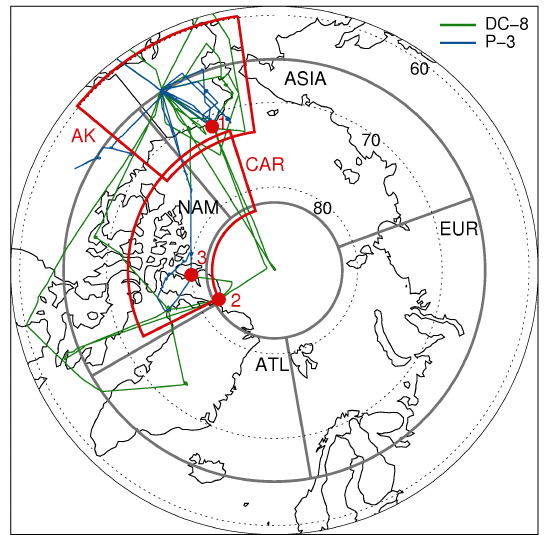
Fig. 4. Arctic map with the location of observations used in this study. Red circles indicate the ground stations: (1) Barrow, (2) Alert and (3) Eureka. The ARCTAS DC-8 (green) and P-3 (blue) flight tracks during April 2008 are also shown. The two regions en- closed by red lines are the domains where CALIOP is compared to ARCTAS measurements: Canadian Arctic (CAR) and Alaska (AK). Grey lines define the four Arctic sectors used in this study: Euro- pean (EUR), Asian (ASIA), North American (NAM) and Atlantic